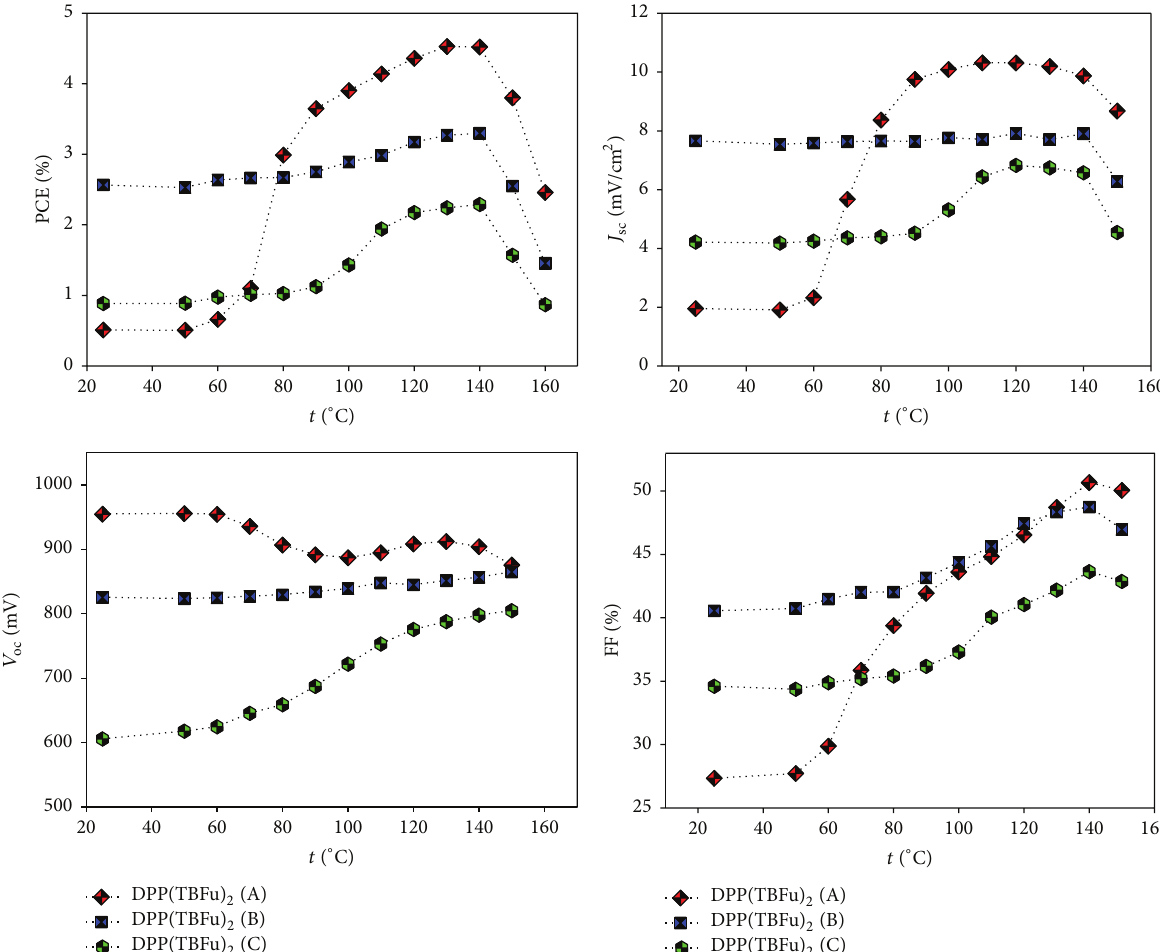
Figure 3: Main photovoltaic parameters of the gradually annealing of the devices with MoO 3 anode layer.